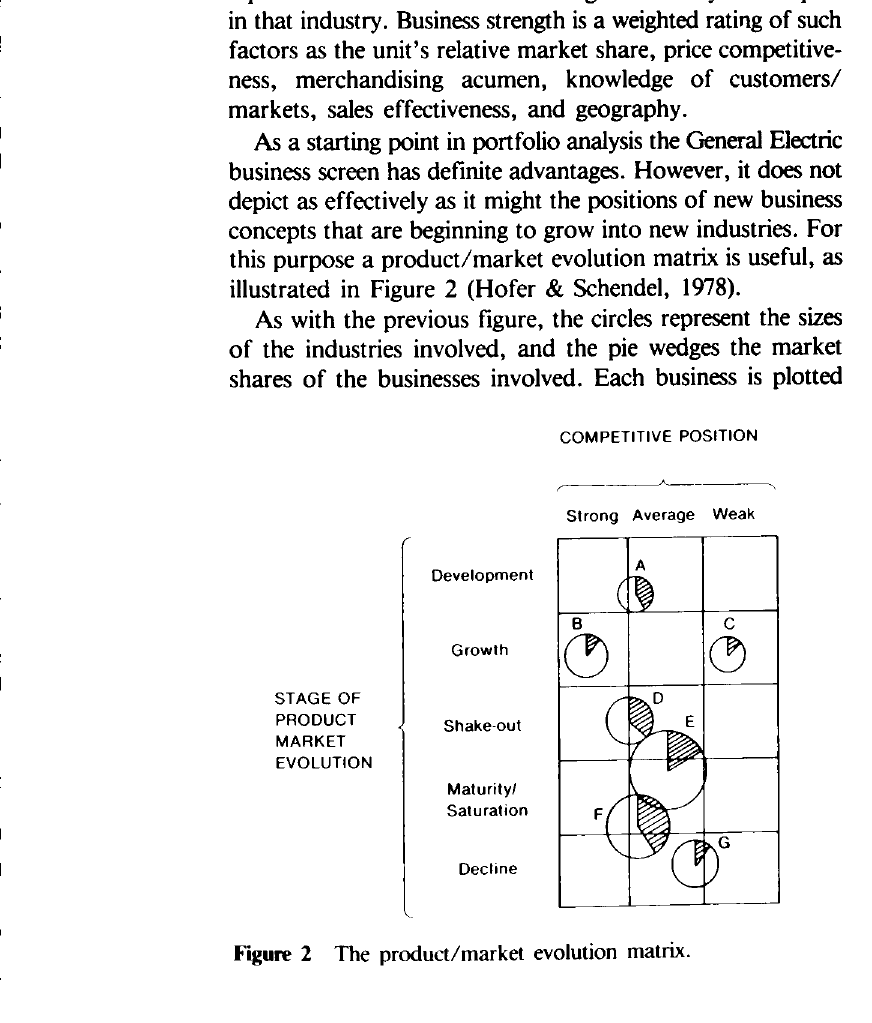
Figure I The General Electric business screen.